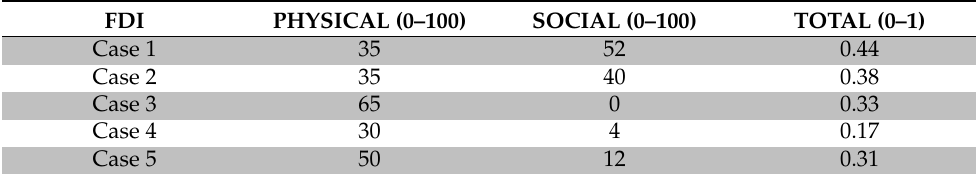
Table 1. Descriptive data of Facial Disability